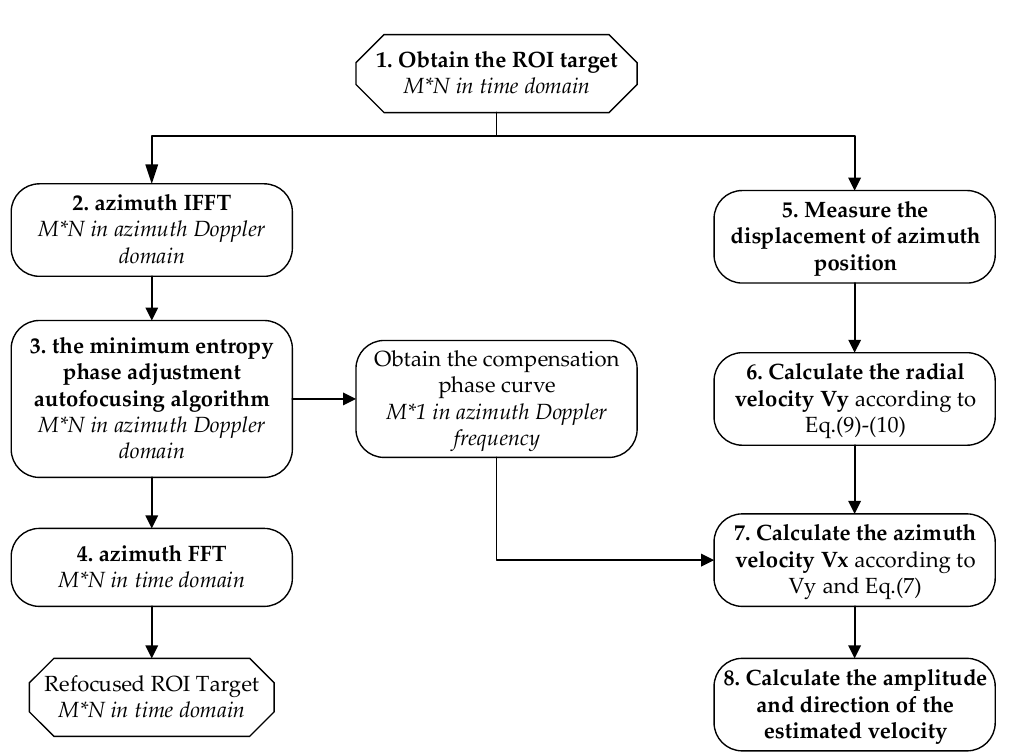
Figure 3. The flowchart of velocity estimation and target refocusing.